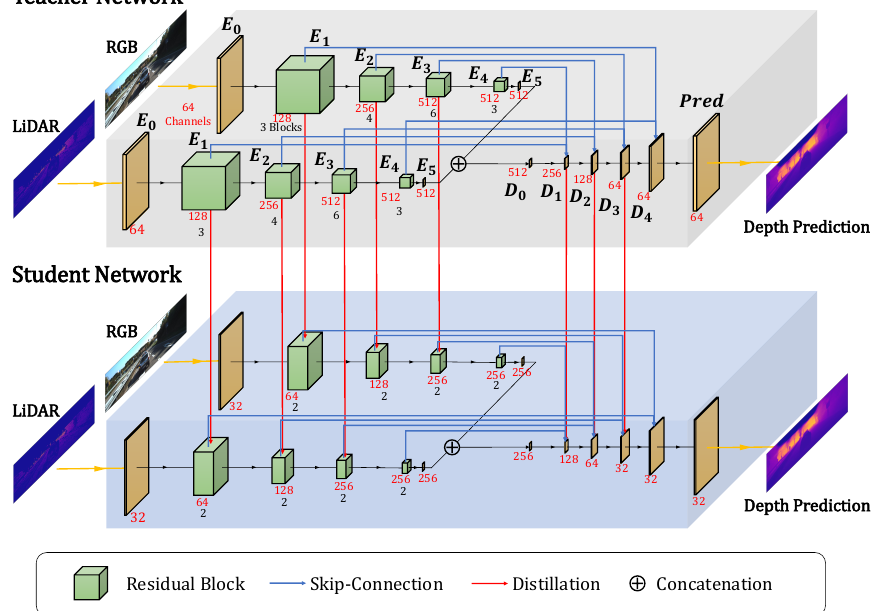
Figure 1. An overall pipeline of the proposed algorithm. The ResNet34-based teacher network consists of two separate encoders for RGB and LiDAR and a decoder for depth prediction. Output feature dimensionalities of each layer are shown together. Encoder features from RGB and LiDAR are concatenated and fed into the decoder. Skip connections deliver encoder features to decoder layers by concatenation. The ResNet18-based student network is distilled with the knowledge from the teacher